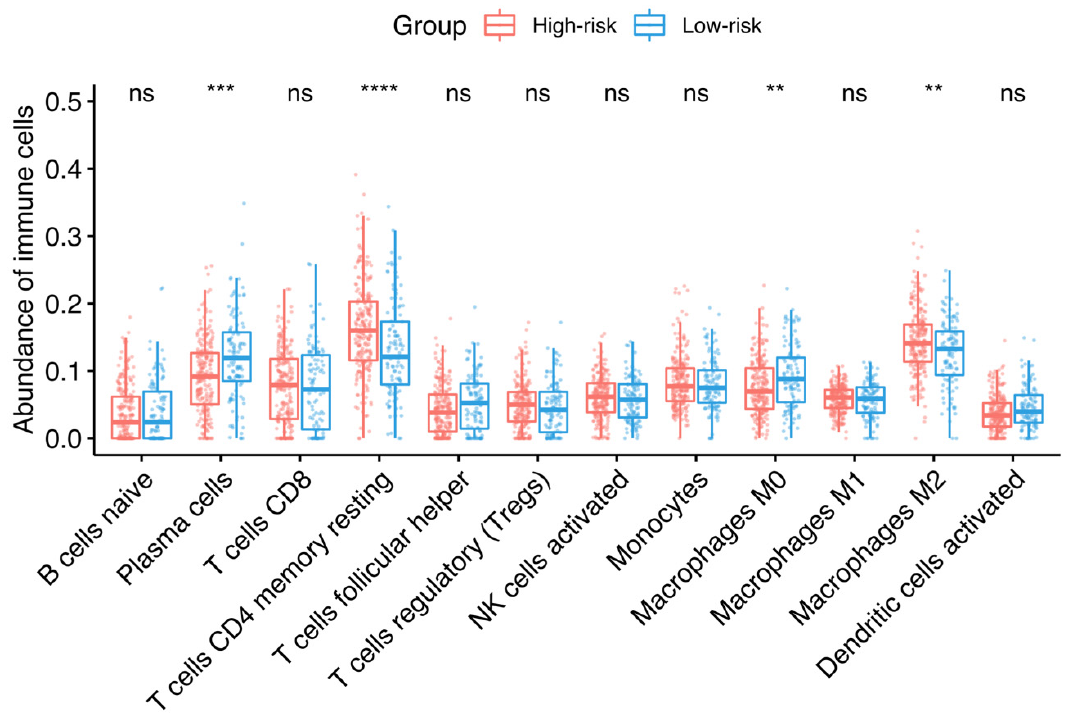
Figure 4. Infiltrating immune cells and HGSOC-TMI risk group. Median percentages of infiltrating immune cells were estimated between each risk group in the OV-TCGA dataset, using CIBERSORTx. The size of the boxes corresponds to the interquartile range (IQR = Q3 − Q1). The whiskers indicate the range from Q1 + 1.5 × IQR to Q3 − 1.5 × IQR. A two-sided unpaired two-sample Wilcoxon test was performed between the two groups: **** p ≤ 0.0001; *** p ≤ 0.001; ** p ≤ 0.01; ns, not significant.